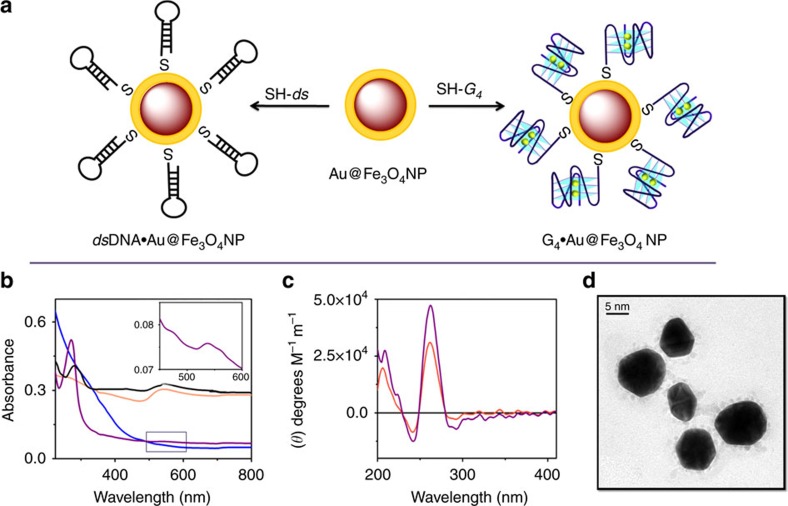
Characterization of G4·Au@Fe3O4 NPs.(a) Schematic diagram of formation of c-MYC G-quadruplex (5′-SH-G4AG3TG4AG3TG4-3′) and duplex DNA (5′-SH-CA5T5GCA5T5G-3′) functionalized Au@Fe3O4 nanoparticles. (b) Absorption spectra of magnetic nanoparticles in Tris-KCl buffer (pH 7.4); blue-Fe3O4 NP, orange-Au@Fe3O4 NP, violet-G4·Au@Fe3O4 and black- dsDNA·Au@Fe3O4 NP. (c) CD spectrum of the thiol-capped c-MYC G-quadruplex oligonucleotide bound nanoparticles (G4·Au@Fe3O4); magenta-10 μM c-MYC G-quadruplex DNA, orange-G4·Au@Fe3O4. (d) TEM image of G4·Au@Fe3O4.